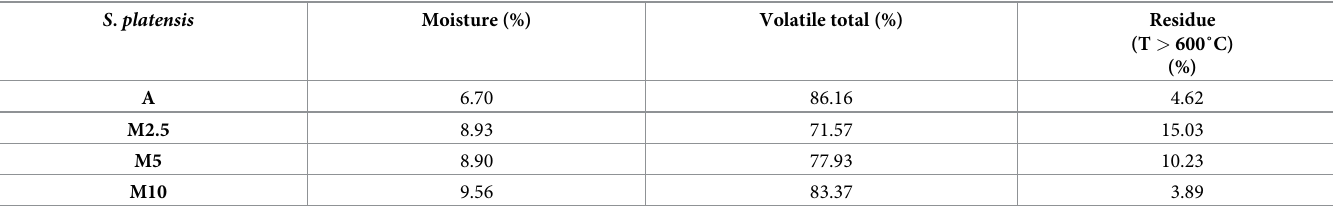
Table 3. TGA data of S . platensis biomass cultivated under autotrophic and mixotrophic conditions. S .